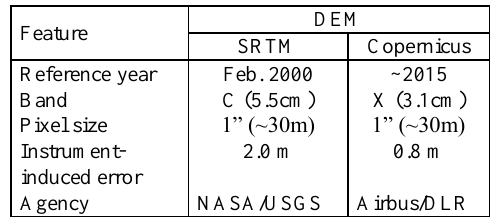
Table 4 . Basic summary of the DEMs used in this project.